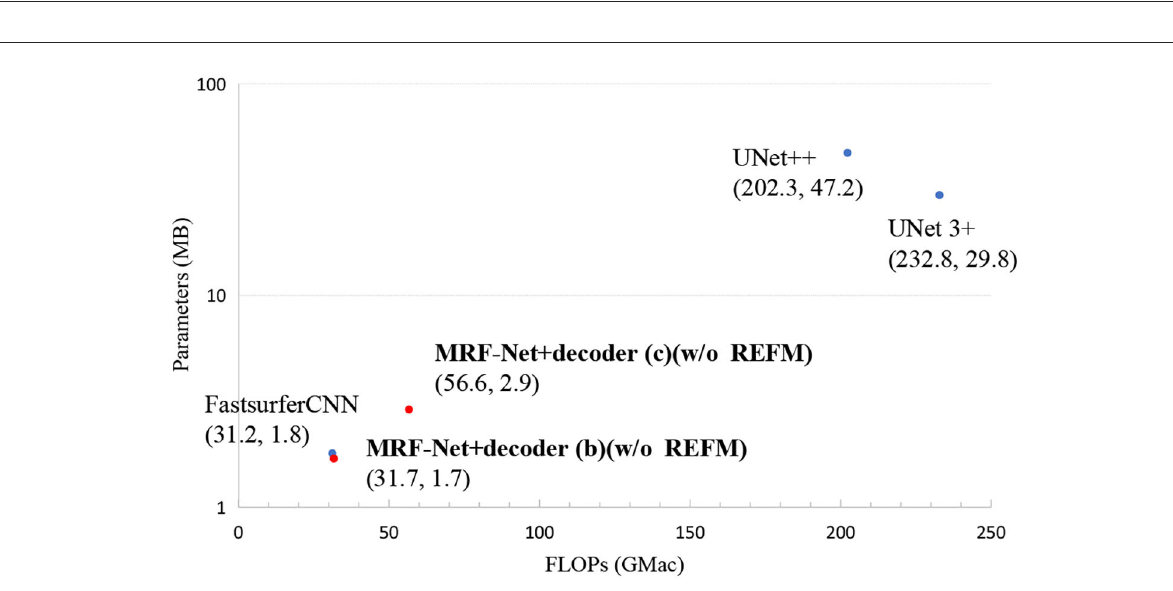
FIGURE4 The FLOPs and total parameters of all networks. Scatter plots show FLOPs and parameters. Each point represents a network with a detailed name and location annotated next to the corresponding point. The results of our networks are